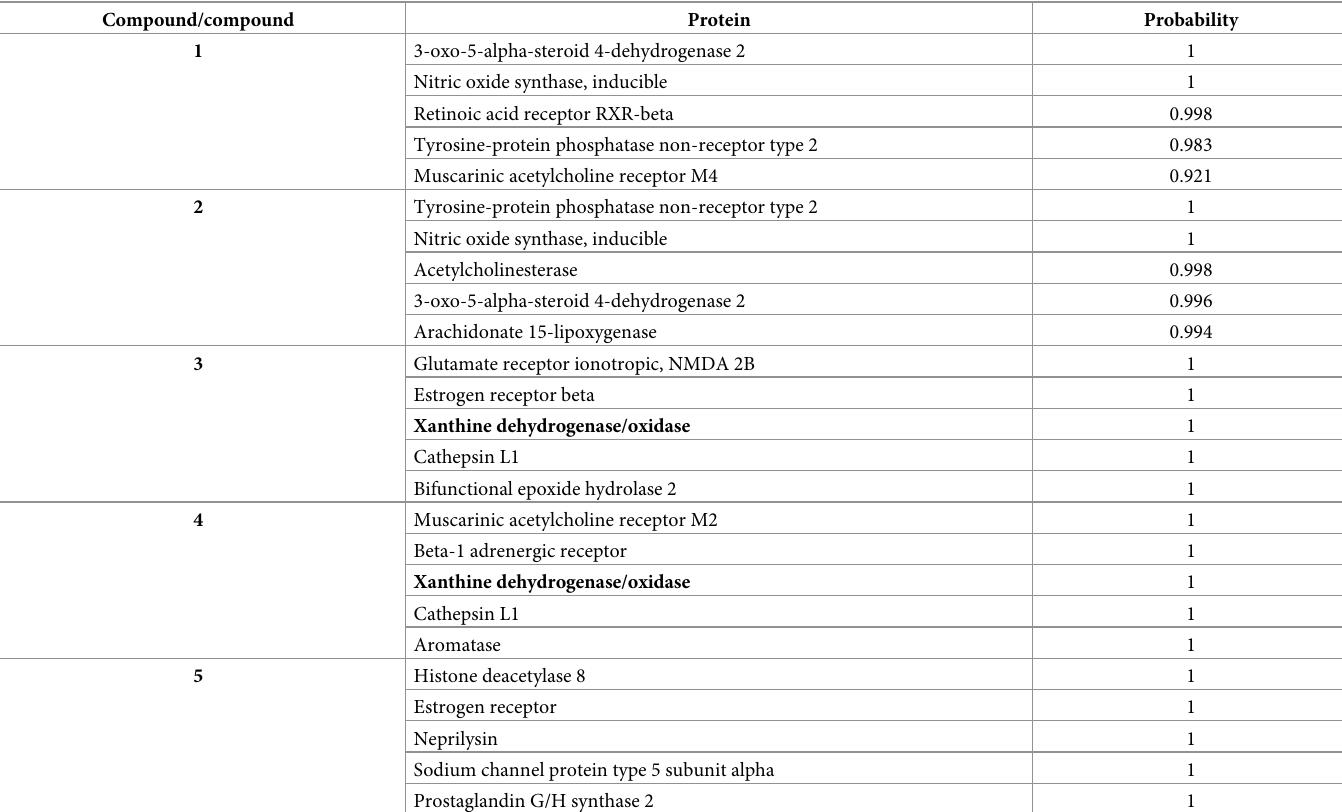
Table 1. Molecular targets of clerodane diterpene predicted using TargetNet. Compound/compound